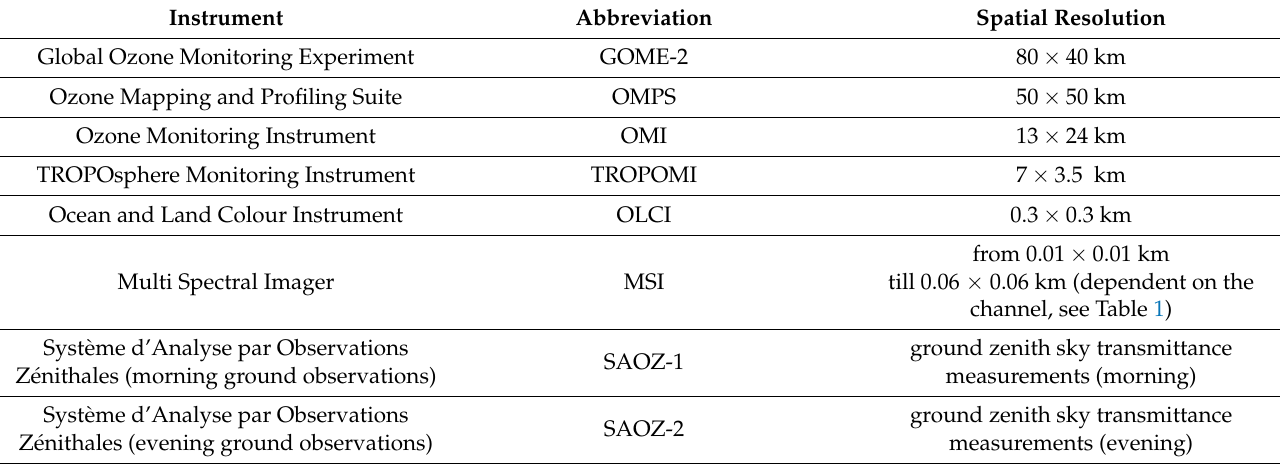
Figure 2. The total ozone column retrieved using MSI/S-2 observations and also other ground and satellite observations (see Table 3) at DOME C (Antarctica) on November–December 2020. The data derived from the ECMWF re-analysis is given as well. Table 3. The instrumentation used in the determination of the total ozone column temporal changes over Dome C (Antarctica) shown in Figure 2. Further details on the satellite instrumentation used are given in [26]